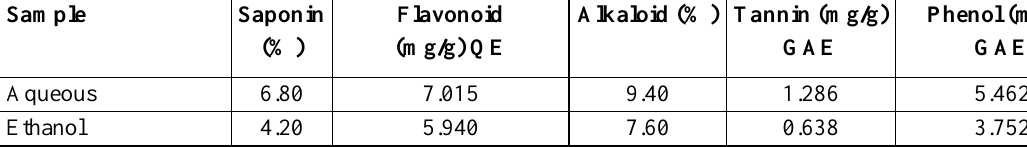
Table 2. Quantitative analysis of phytochemicals.